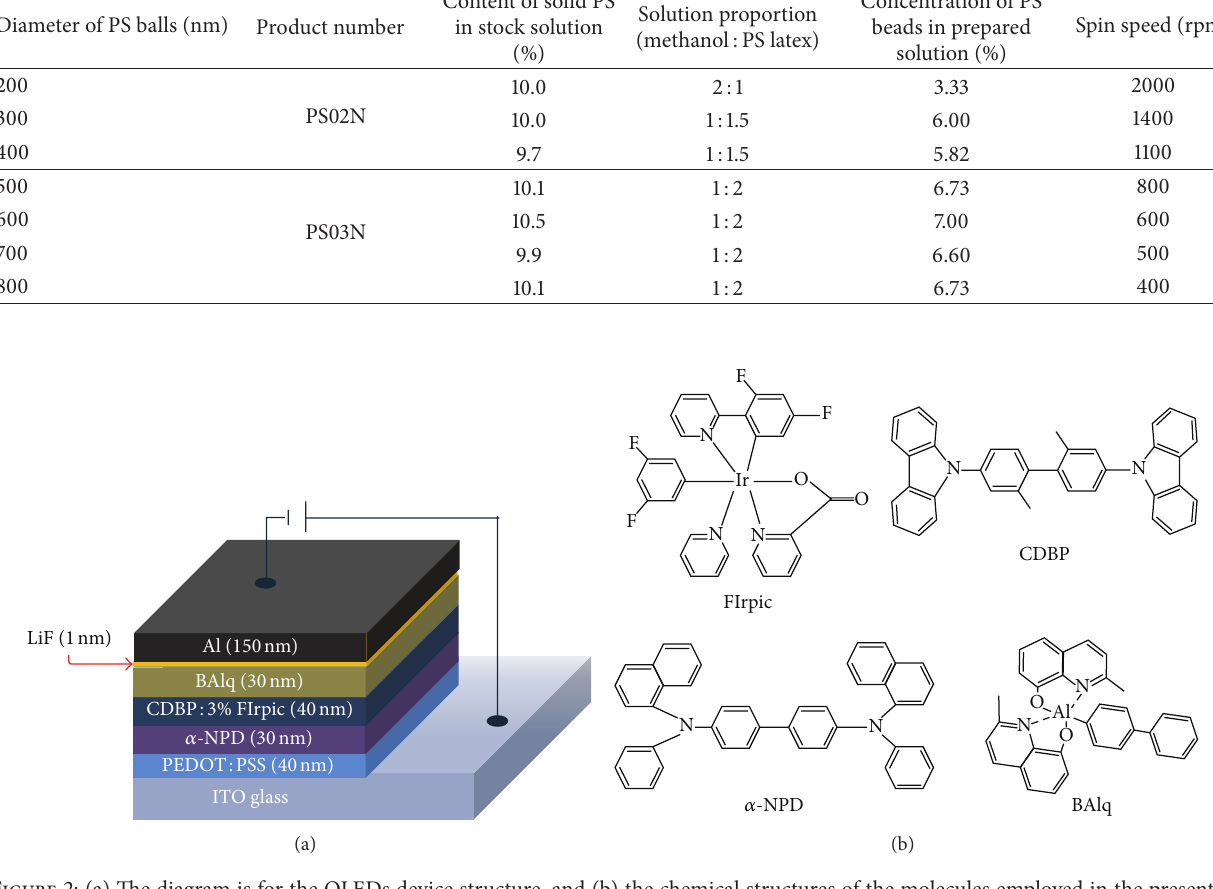
Figure 2: (a) The diagram is for the OLEDs device structure, and (b) the chemical structures of the molecules employed in the presented research